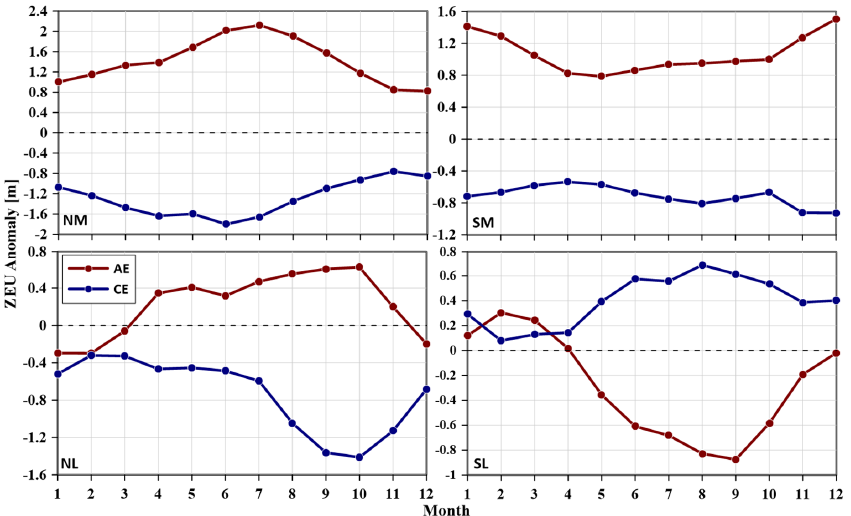
Figure 4. Seasonal variation of ZEU′ in eddy inside. The matched daily ZEU′ in AE/CE was divided into 4 latitude zones (NM, SM, NL, and SL) and then each month mean values were calculated over the 23 years.